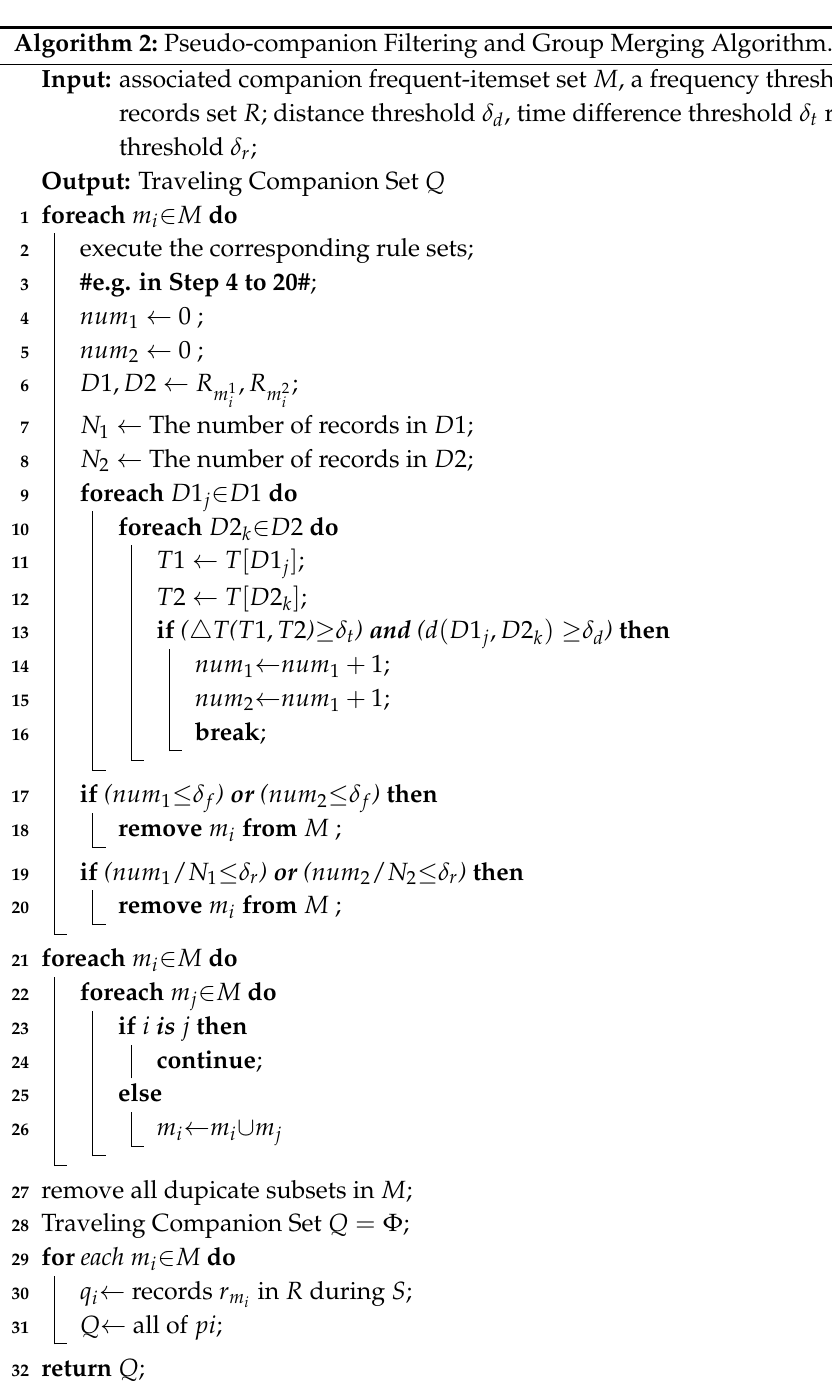
Algorithm 2: Pseudo-companion Filtering and Group Merging